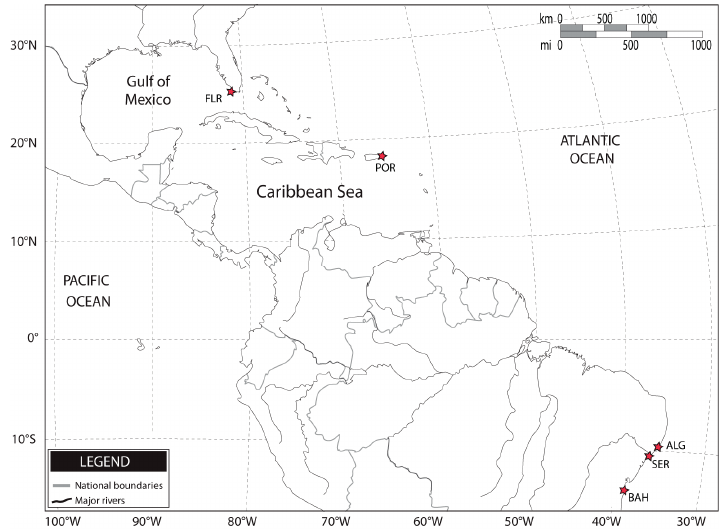
Figure 1. Sampling sites in the Western Central Atlantic